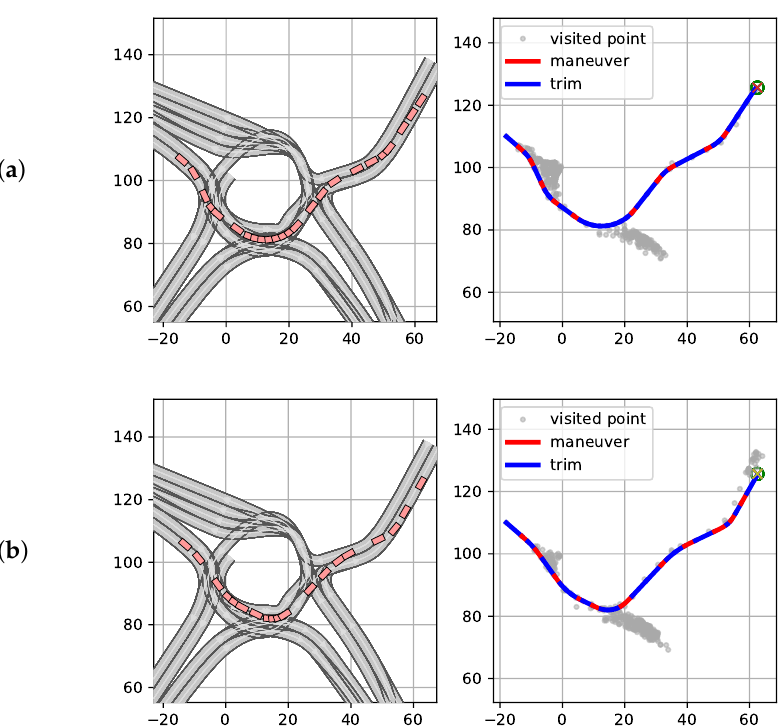
Figure 11. Trajectories for the smallest extracted automata: ( a ) with four trims; ( b ) with seven trims.